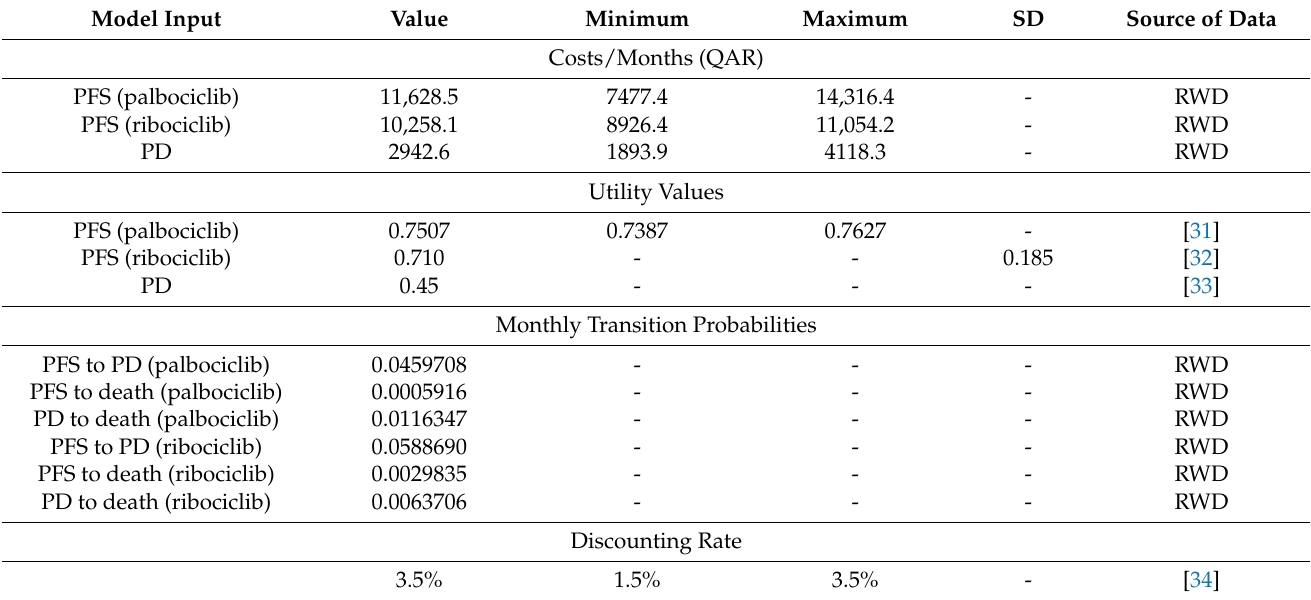
Table 1. Inputs of the Markov